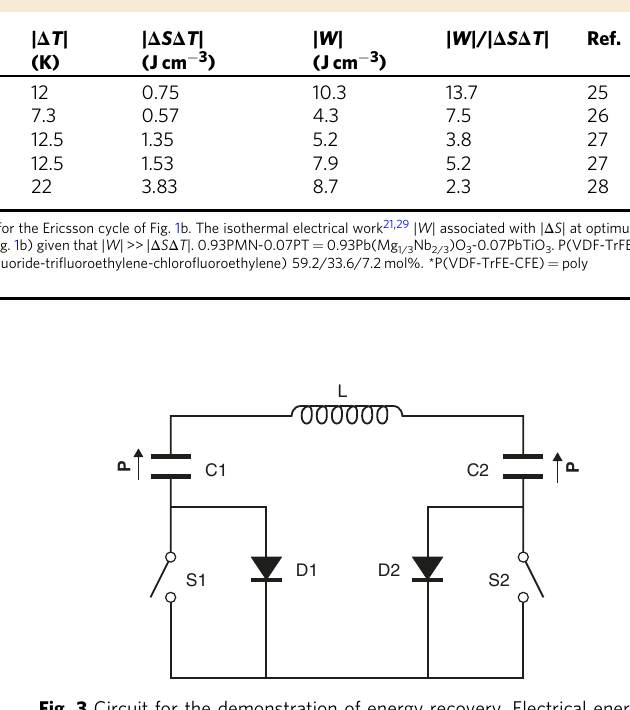
Fig. 3 Circuit for the demonstration of energy recovery. Electrical energy was passed via inductor L between EC capacitors C1 and C2, which are poled ferroelectric MLCs with a variable polarization P of fi nite magnitude and fi xed direction. Switches S1 and S2, and diodes D1 and D2, prevented resonance so that heat could fl ow between each charge-transfer event (see Methods). For simplicity, we do not show the Sourcemeter used to inject the initial charge into C1 and subsequently measure its voltage, or the Sourcemeter used to measure voltage across